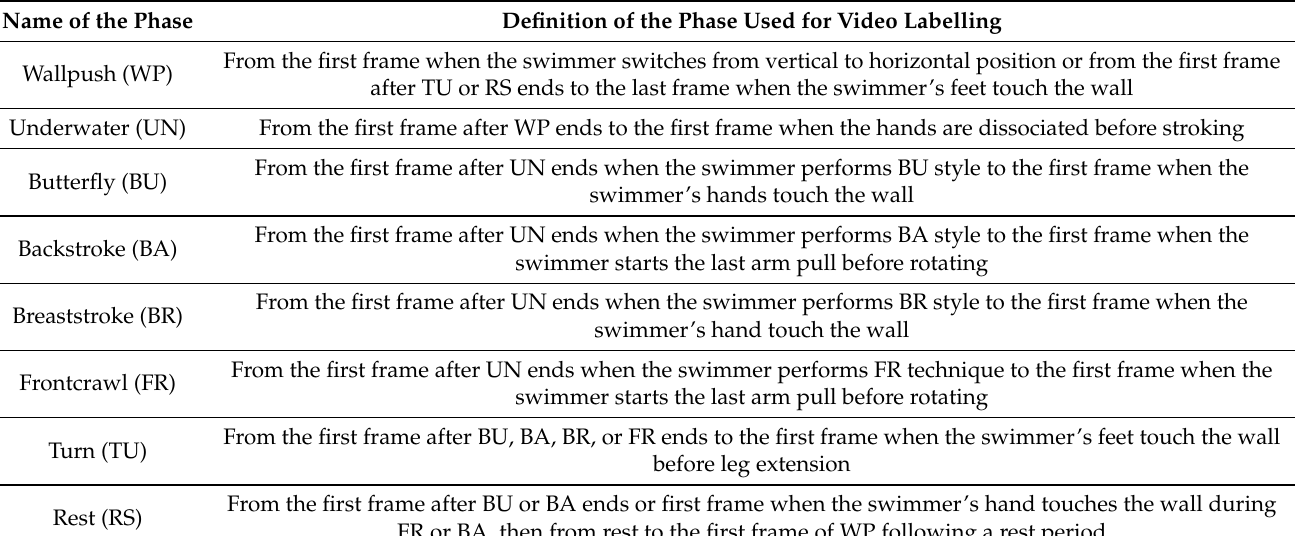
Table 1. Phase identification used in video labelling and then for feeding into the